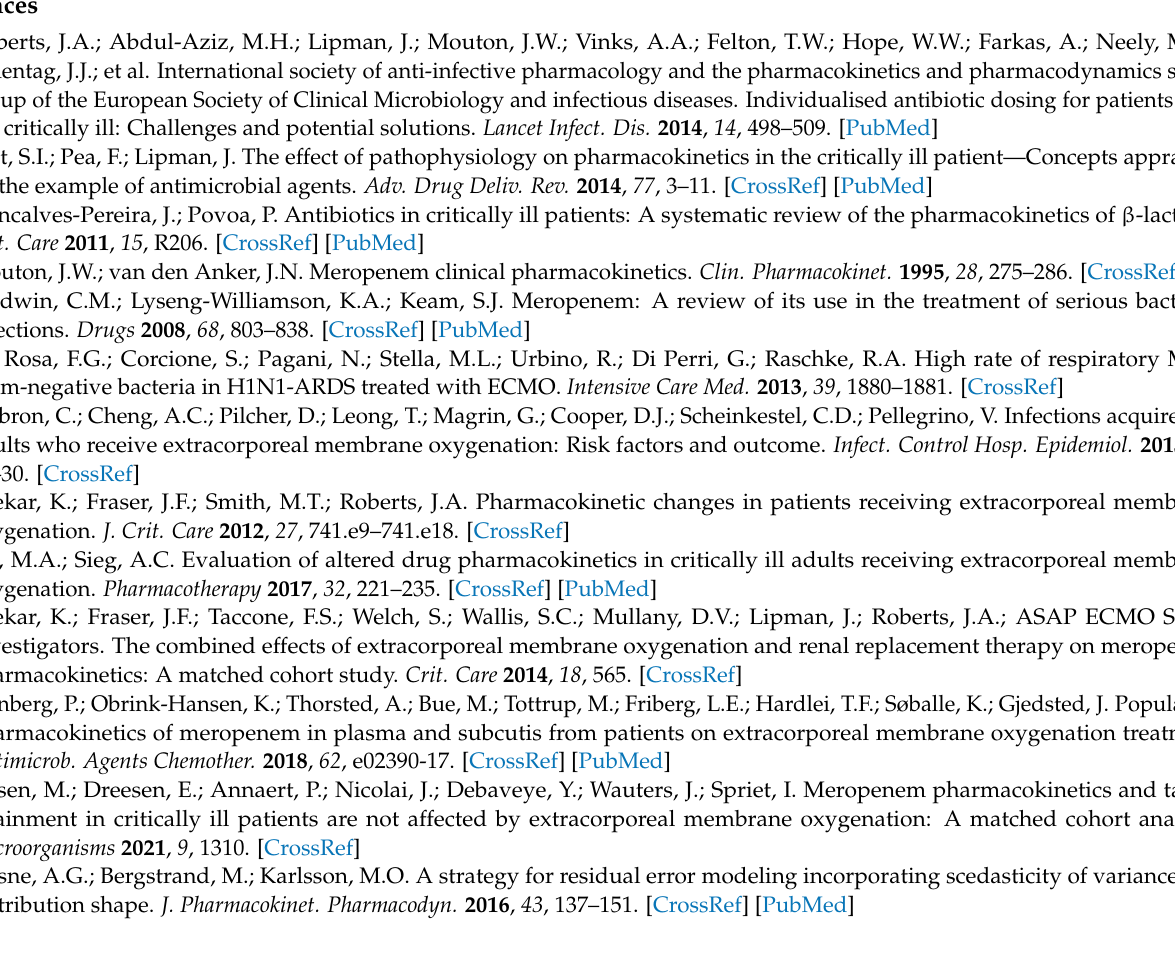
Figure S2: Relative prediction errors vs observations for the final population pharmacokinetic model of meropenem: (a) plots for all subjects ( n = 26), (b) plots excluding the two patients with extreme values ( n =